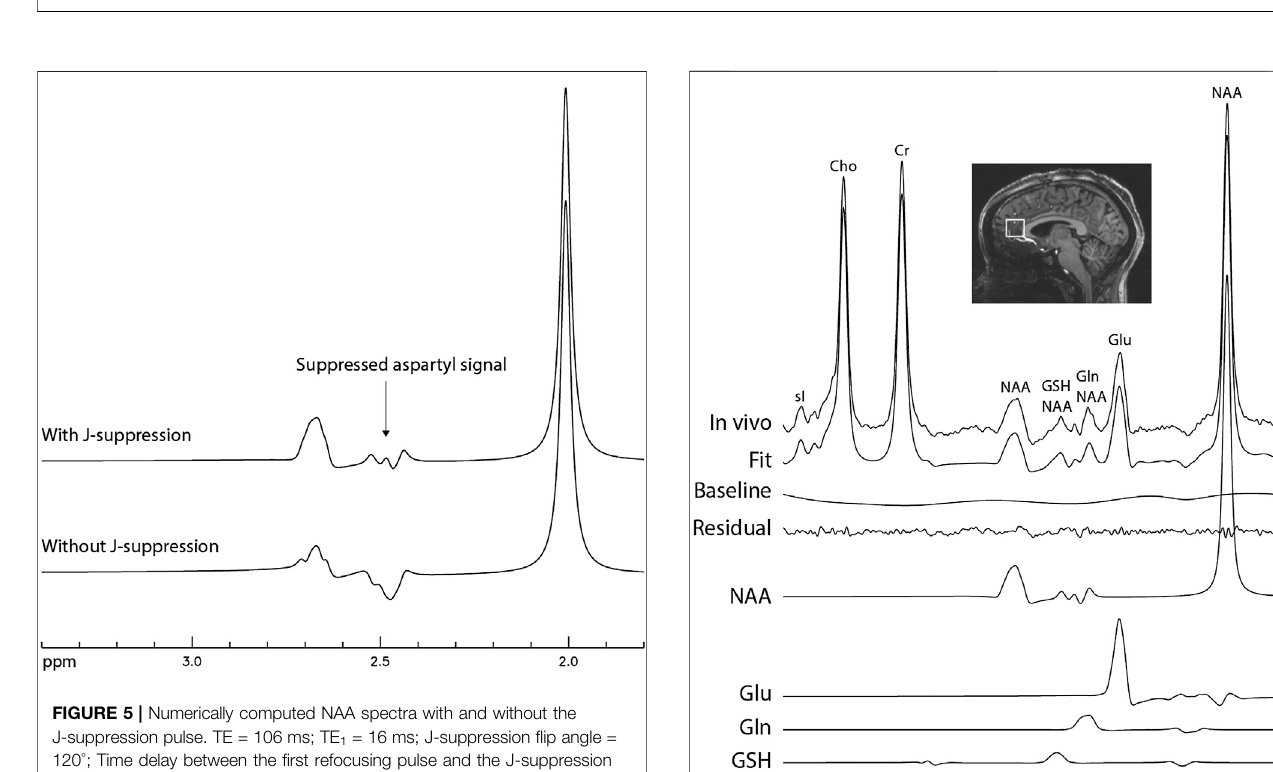
FIGURE4| Peak amplitude vs. TE 1 curves bydensity matrix simulations forTE=100 ms (A) and 110 ms (B) . Thepeak amplitudes werenormalizedrelativetothe NAA singlet.